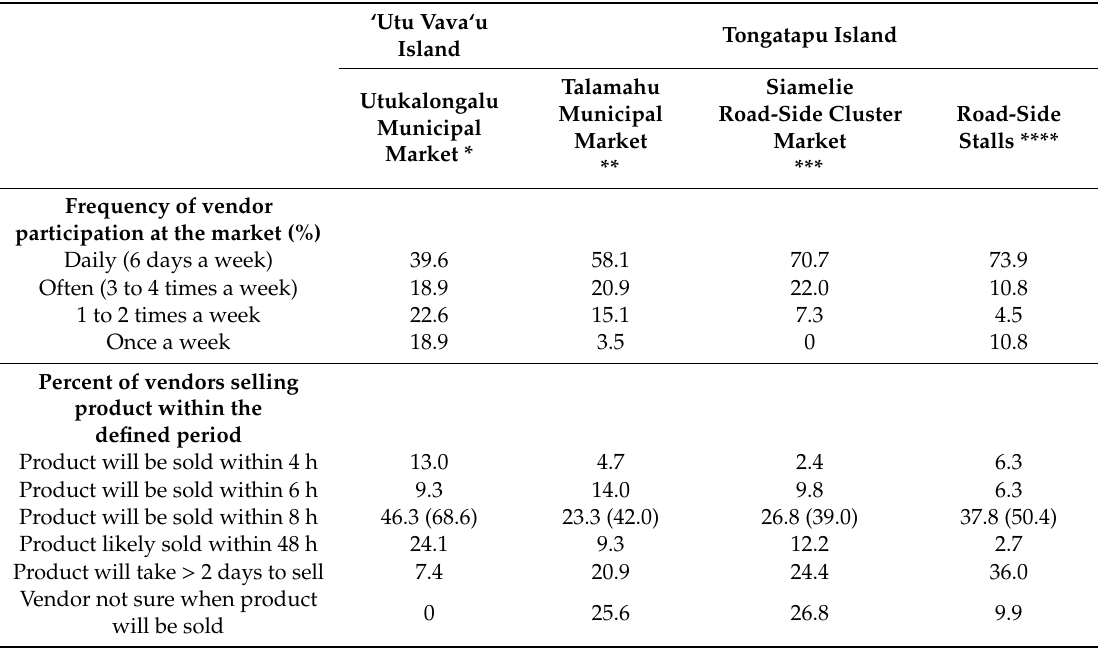
Table 2. Frequency of vendor market participation and relative rate of product trading in fruit and vegetable markets on ‘Utu Vava’u and Tongatapu Islands,